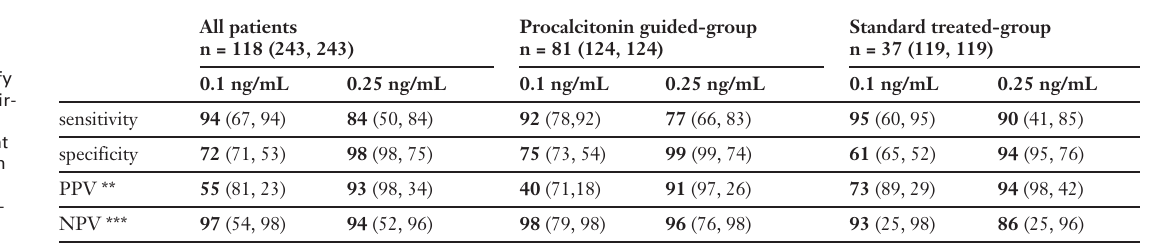
Table 4 Usefulness of pro- calcitonin to identify bacterial LRTI requir- ing antibiotic ther- apy. Three different analyses are shown (x, y, z). x excludes patients with possi- ble bacterial infec- tion, y includes patients with possi- ble bacterial infection classed as bacterial LRTI, and z includes patients with possi- ble bacterial infection classed as self-limit- ing